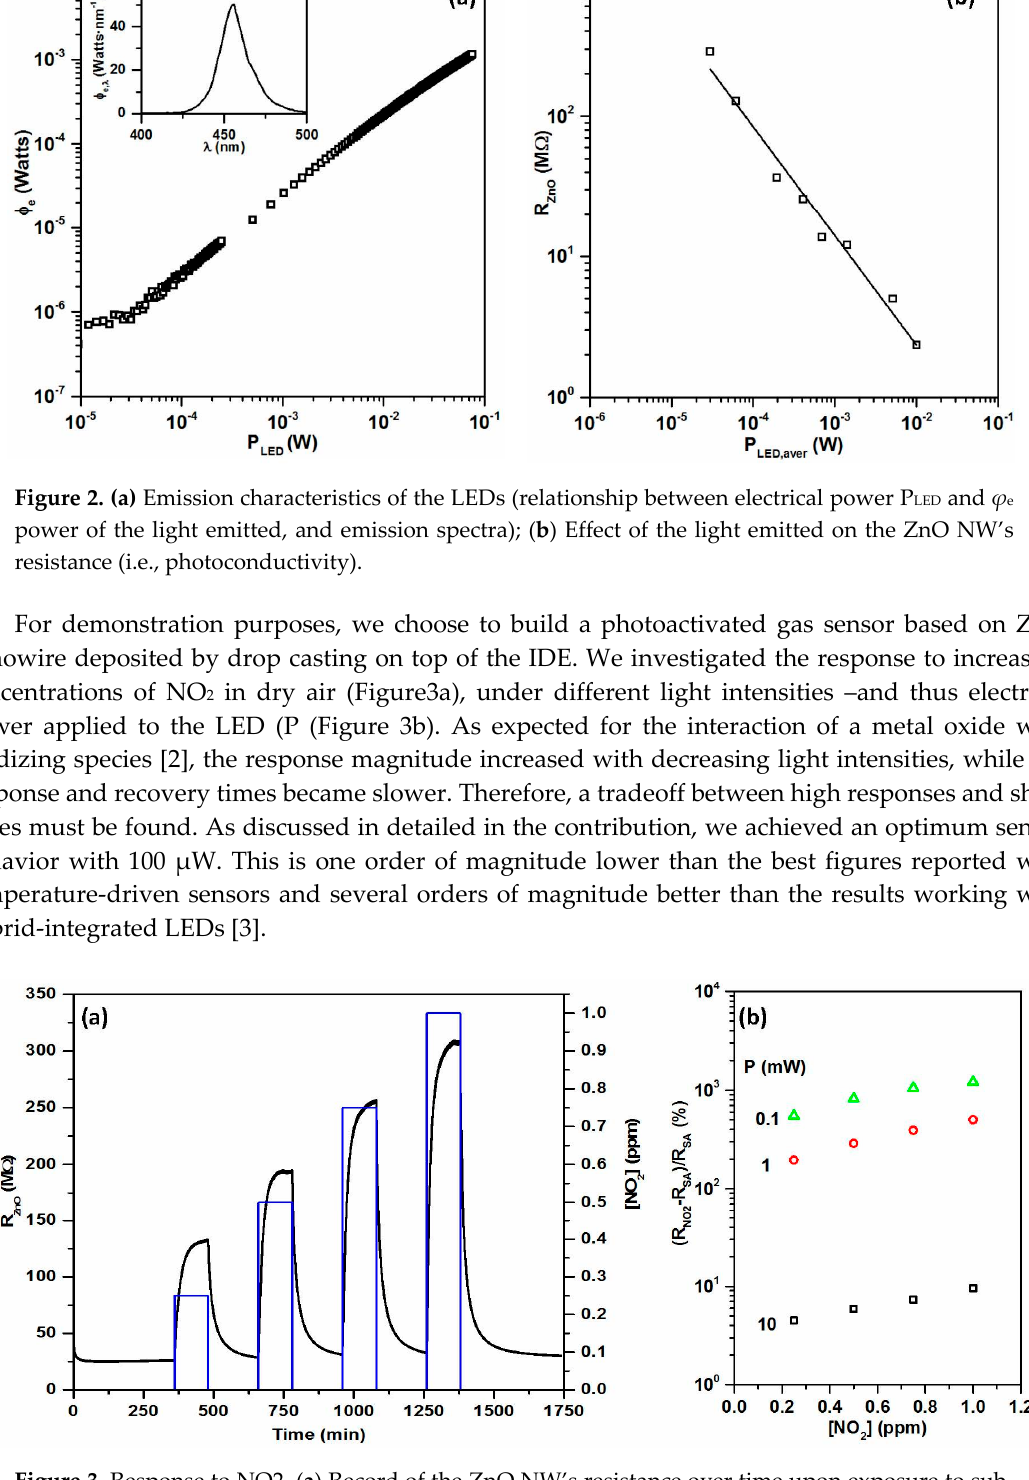
Figure 3. Response to NO2. ( a ) Record of the ZnO NW’s resistance over time upon exposure to sub- ppm concentrations of NO2. ( b ) Summary of the responses obtained under different electrical powers levels applied to the